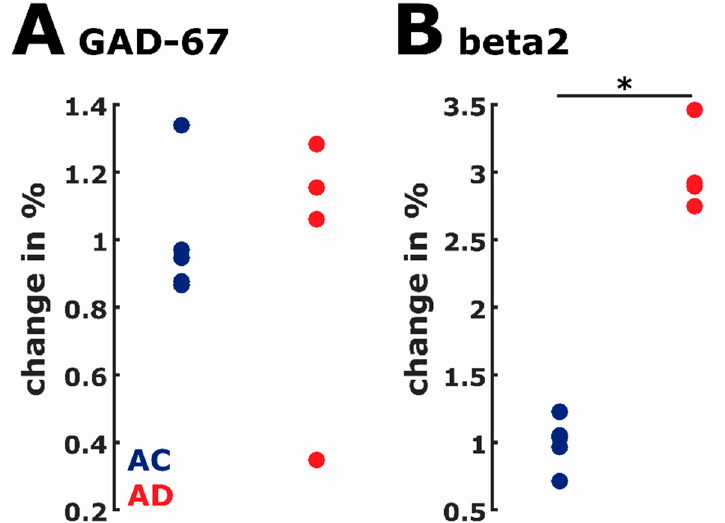
Figure 7. Dot plots of the relative change in protein expression normalized to beta-actin expression. ( A ) GAD-67 expression was not different between the groups indicating no significant change (AUC: 0.60, 95% CI: 0.2 to 1) in the amount of GABA produced; note that the highest value in the AC group and the lowest value in the AD group could be considered outliers as evaluated by the Grubbs’s